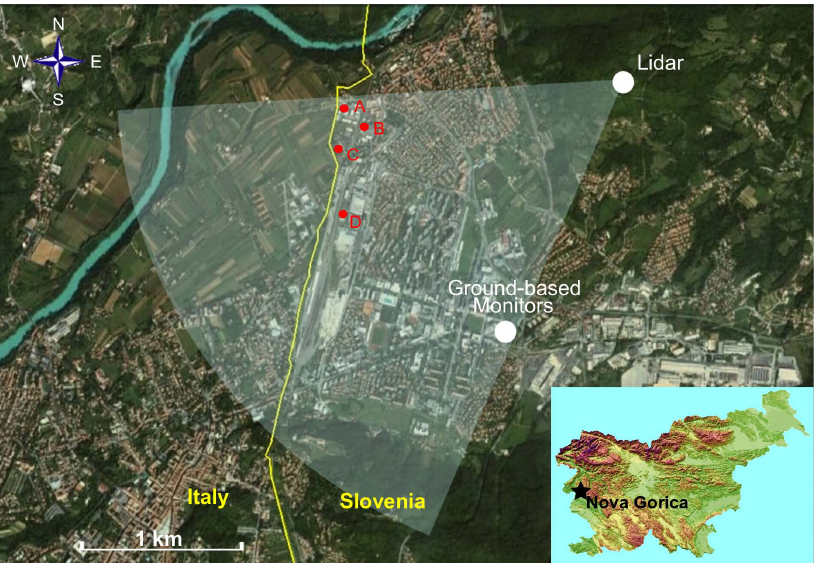
Fig. 1. Top view of the scanning region (light-colored shadow) and the LIDAR site (45.96 ◦ N, 13.64 ◦ E, 305ma.s.l., 200m above the town). PM 10 , NO x and meteorological data were monitored at the ground level. Red points denote the locations of the identified aerosol sources and the yellow line the border between Slovenia and